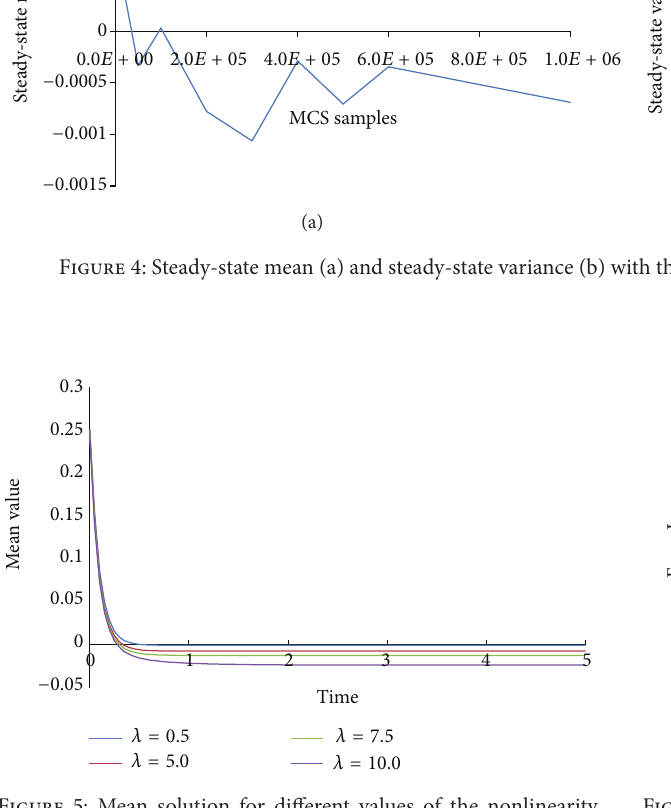
Figure 5: Mean solution for different values of the nonlinearity strength 𝜆 .